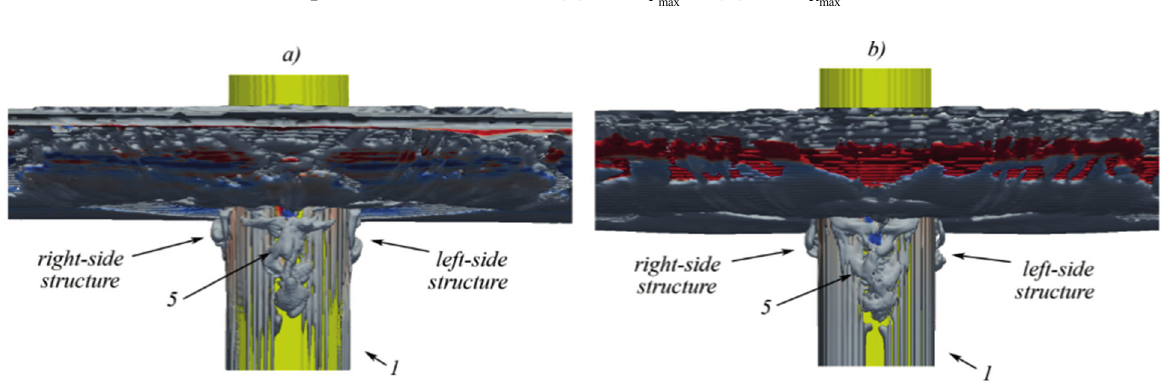
Figure 16. Close-up at the cylinder surface of inviscid-flow structures as obtained from the solution of the Euler equations. Side view: ( a )